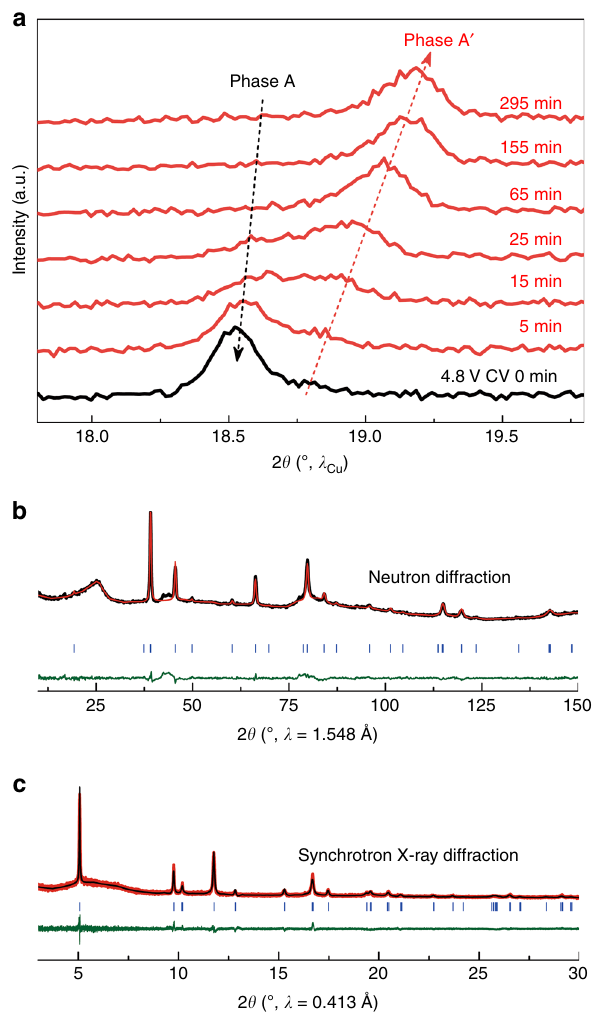
Fig. 1 Lattice densi fi cation of Li-rich NMC on deep oxidation. a Selective region of the operando XRD patterns (around the (0 0 3) diffraction peak) collected at the end of 4.8 V charge (denoted as 4.8 V CV 0 min) and during the 5 h CV hold at 4.8 V. Note that phase A refers to the charged Li- rich NMC phase (the parent (0 0 3) peak), whereas phase A ′ refers to the new peak developed at the high-angle side of the parent (0 0 3) peak. Rietveld re fi nement of neutron powder ( b ) and synchrotron X-ray ( c ) diffraction for the A ′